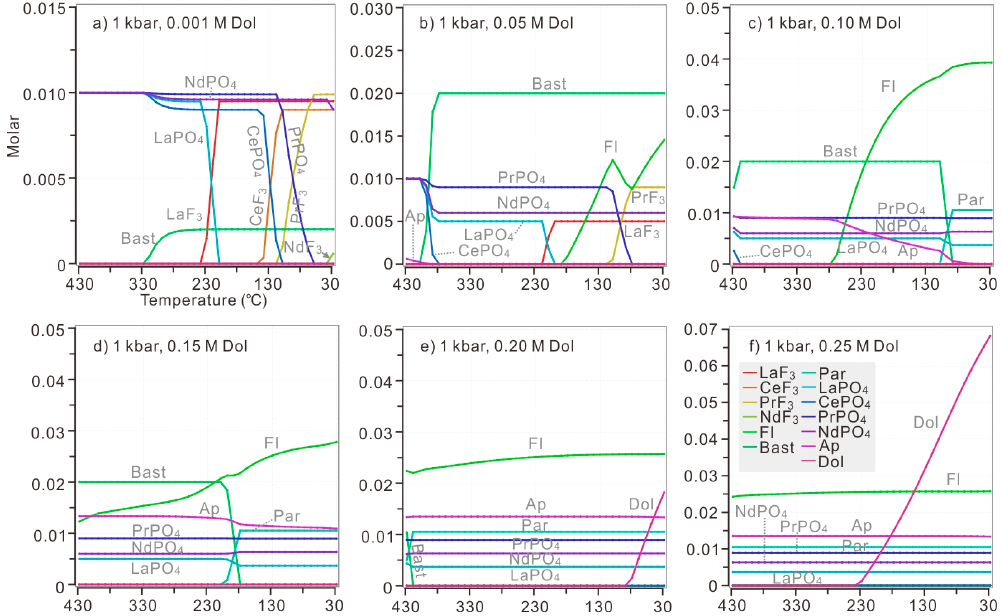
Figure 9. The precipitation of REE minerals in a continuous range of temperatures (30–430 °C) when discrete amounts of dolomite were added into a modelled solution, with 0.1 M HCl, 0.1 M HF, 0.1 M H 3 PO 4 , 0.1 M LaCl 3 , 0.1 M CeCl 3 , 0.1 M PrCl 3 and 0.1 M NdCl 3 . All calculations were performed under the pressure of 1 kbar. The discrete amount of dolomite added into the initial fluids include ( a ) 0.001 M; ( b ) 0.05 M; ( c ) 0.10 M; ( d ) 0.15 M; ( e ) 0.20 M; and ( f ) 0.25 M. The temperature decreased 10 °C per step.